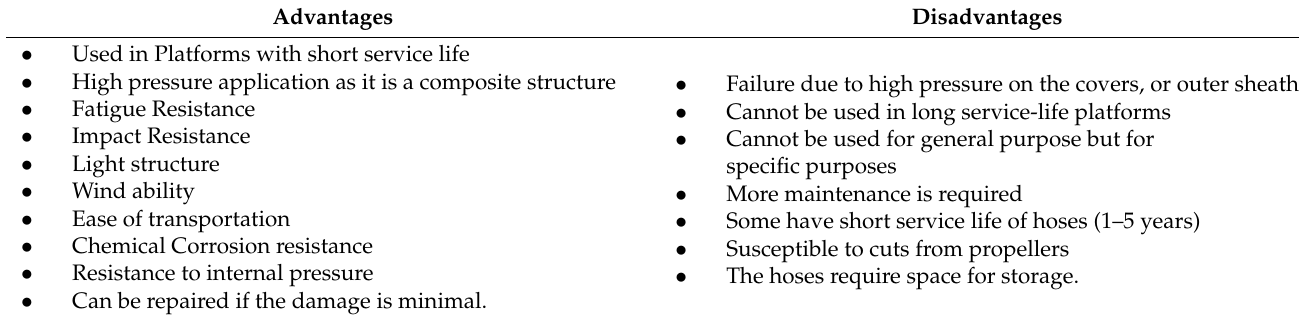
Table 9. Pros and Cons of offshore hoses.